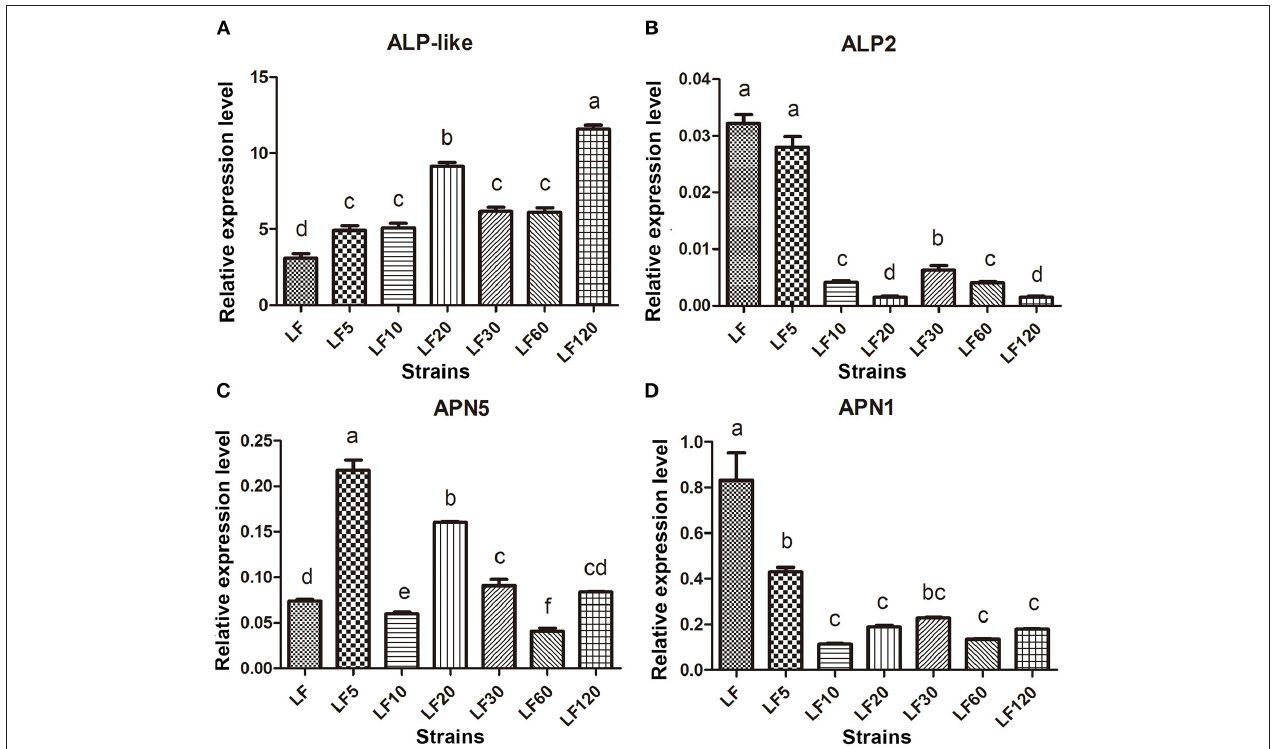
FIGURE 4 | The qRT-PCR estimates of transcript abundances among candidate Bt-resistance receptor genes within H. armigera -susceptible (LF) and -resistant (LF5, LF10, LF20, LF30, LF60, and LF120) strains. (A-D) Represent the relative expression levels of ALP-like, ALP2, APN5 and APN1 in resistance strains, respectively. Values shown are means and standard errors. Different letters indicate significant differences between treatments ( P < 0.05; HSD